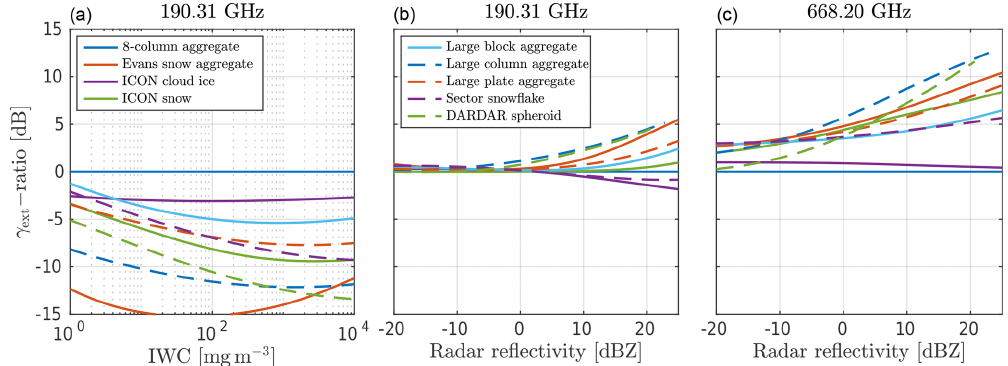
Figure 7. Ratios of the extinction coefficient γ ext as a function of IWC (a) and radar reflectivity (b, c) . The ratios are calculated by dividing γ ext of given particle model by γ ext of the 8-column aggregate. Hence, the 8-column aggregate appears as a straight line. The frequencies are 190.31GHz (a, b) and 668.2GHz (c) . PSD is F07T, and temperature is